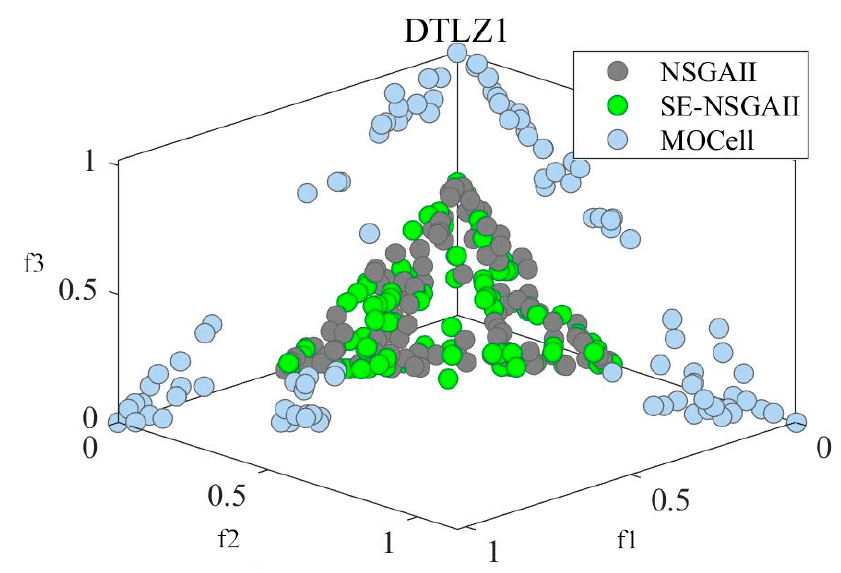
Figure 5. Statistical results of the Pareto front in comparison.